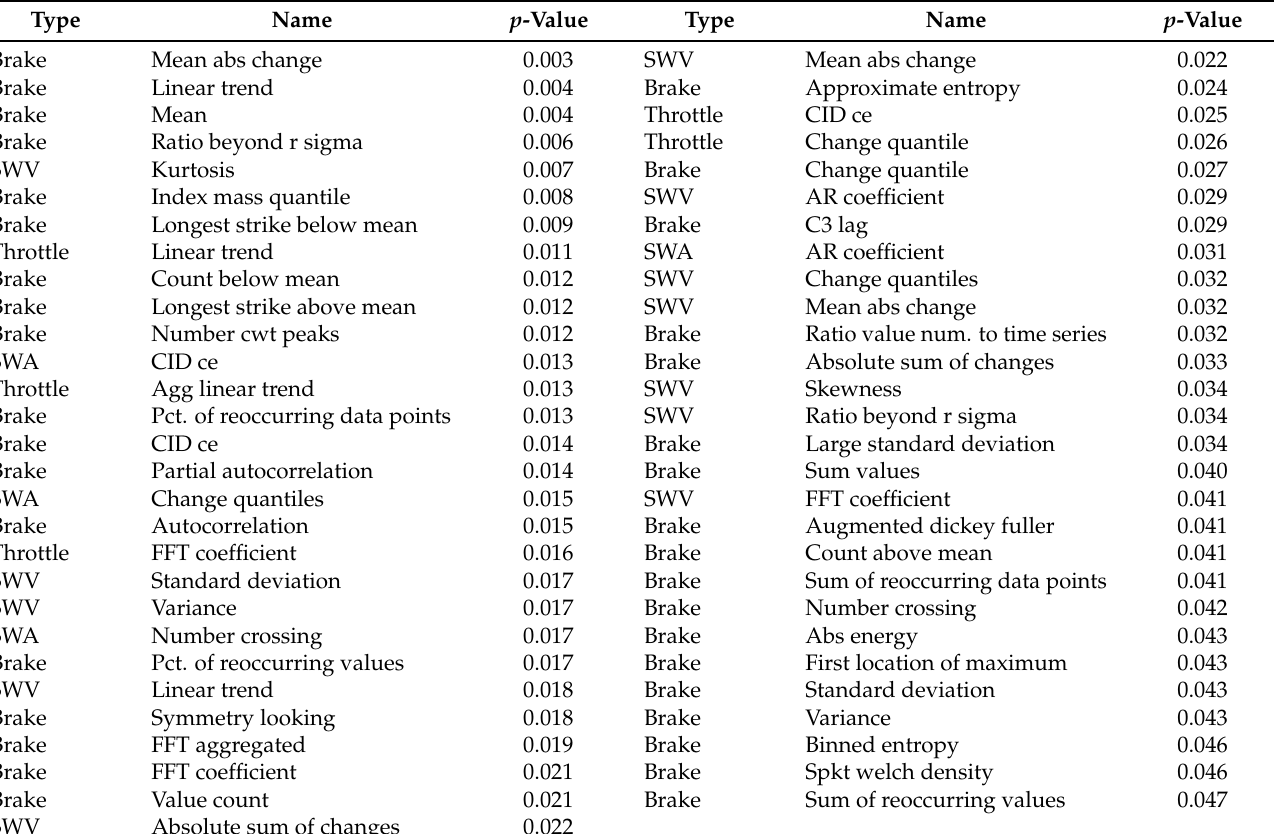
Table 2. Significant feature list for short duration of drowsy driving (SD)